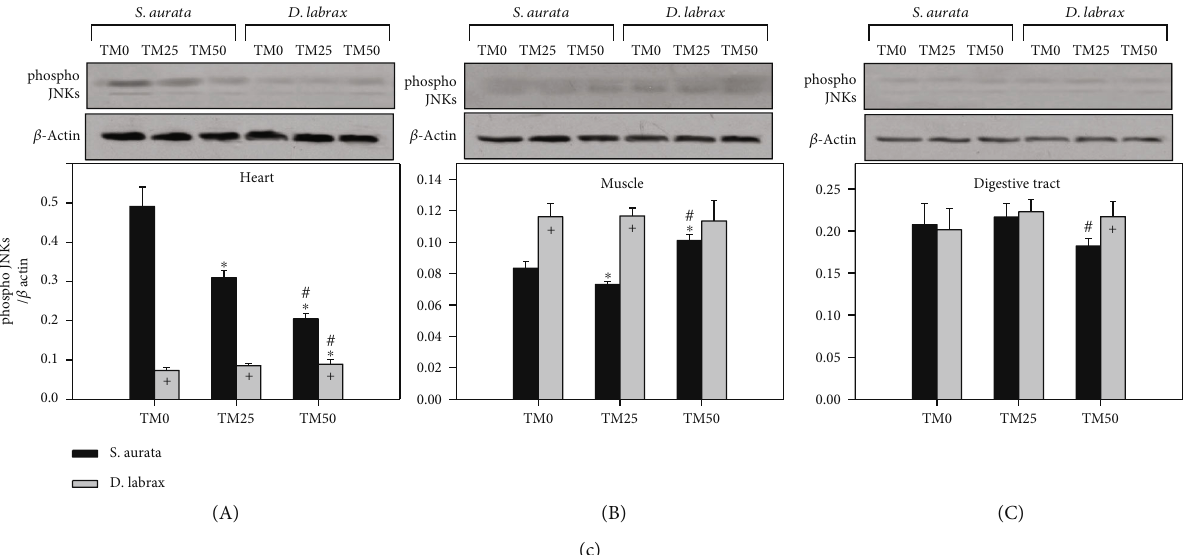
Figure 2: Phosphorylation of p38 MAPK (a), p44/42 MAPK (b), and JNKs (c) in the heart (A), muscle (B), and digestive tract (C) of gilthead sea bream ( S. aurata ) and European sea bass ( D. labrax ) under the 0% (TM0), 25% (TM25), and 50% (TM50) T. molitor inclusion diet treatment. Representative immunoblots are shown and were quanti fi ed by laser scanning densitometry and plotted. Values represent means ± SD ; n = 5 preparations from di ff erent animals. ∗ indicates p < 0 : 05 compared with 0%, # indicates p < 0 : 05 compared with 25%, and + indicates p < 0 : 05 between species at the same TM